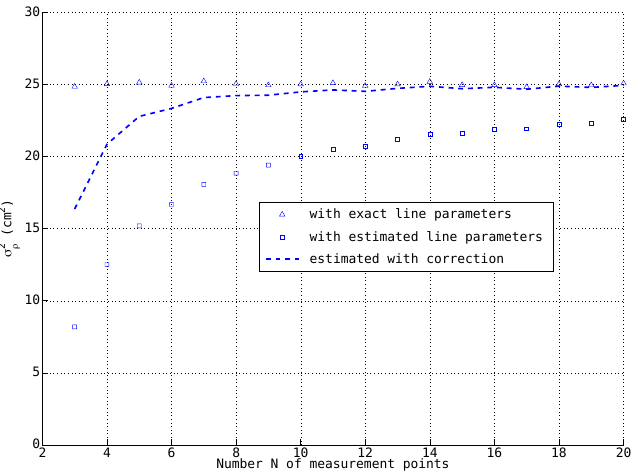
Figure 6. Variance of ρ dependent on the number N of measured data points, using the same simulation parameters as indicated in Figure 5a.